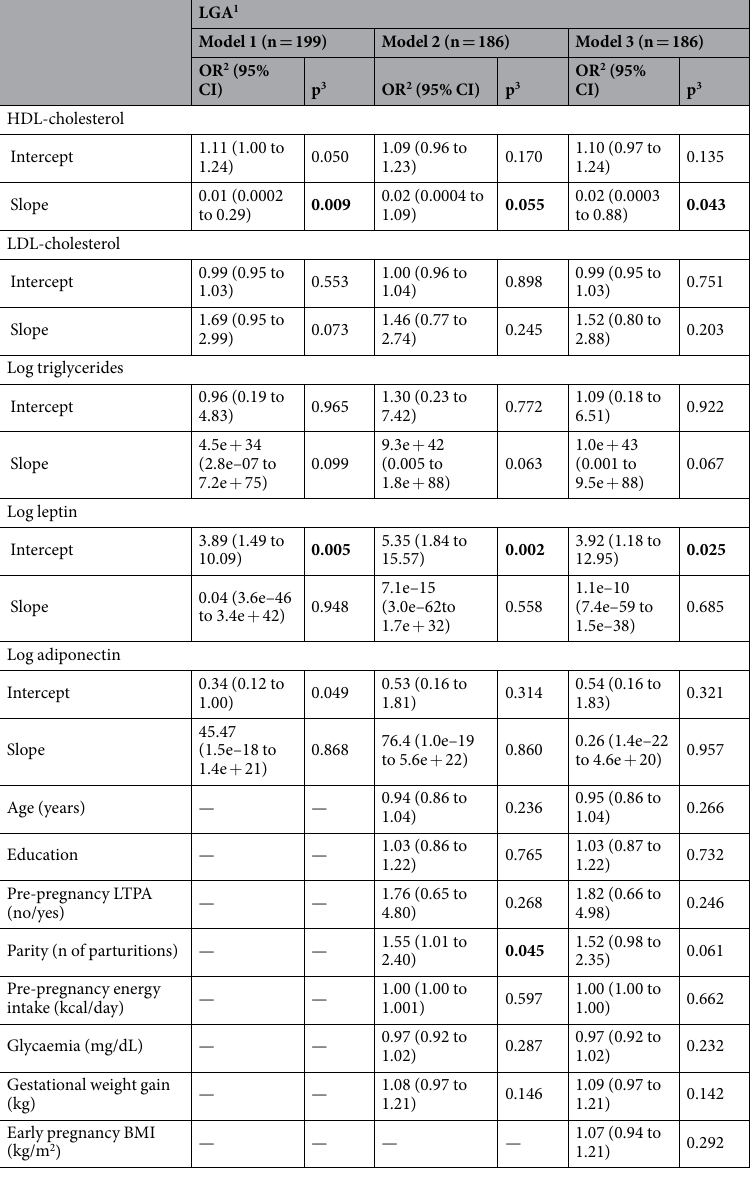
Table 4. Logistic regression between maternal lipids, log leptin and log adiponectin time trends during pregnancy and large-for-gestational-age (LGA) 1 in a sample of women and their newborns followed at a public health centre in Rio de Janeiro city, Brazil, 2009–2012. 1 LGA was classified according to the international foetal and newborn growth consortium for the 21 st Century (Intergrowth-21 st ) curves. 2 Odds ratio. 3 p-value refers to the logistic regression. Notes: Intercept variables represent the prediction of the mean exposure level, i.e. biomarkers concentrations when the gestational age was zero and the slope the trend of change in concentrations during pregnancy. Model 1 included lipids, leptin and adiponectin intercepts and slopes variables; Model 2 was additionally adjusted for women’s age, education, parity, pre-pregnancy practice of leisure time physical activity, pre-pregnancy energy intake, glycaemia and gestational weight gain. Model 3 was additionally adjusted for early pregnancy BMI. The models were not adjusted by smoking habit since none of the mothers of LGA smoked during pregnancy. Abbreviations: CI = confidence interval; HDL-c = high-density lipoprotein; LDL-c = low-density lipoprotein; LGA = large-for-gestational-age; LTPA = leisure time physical